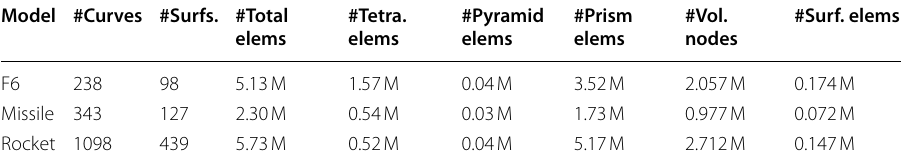
Table 2 Statistics of the selected